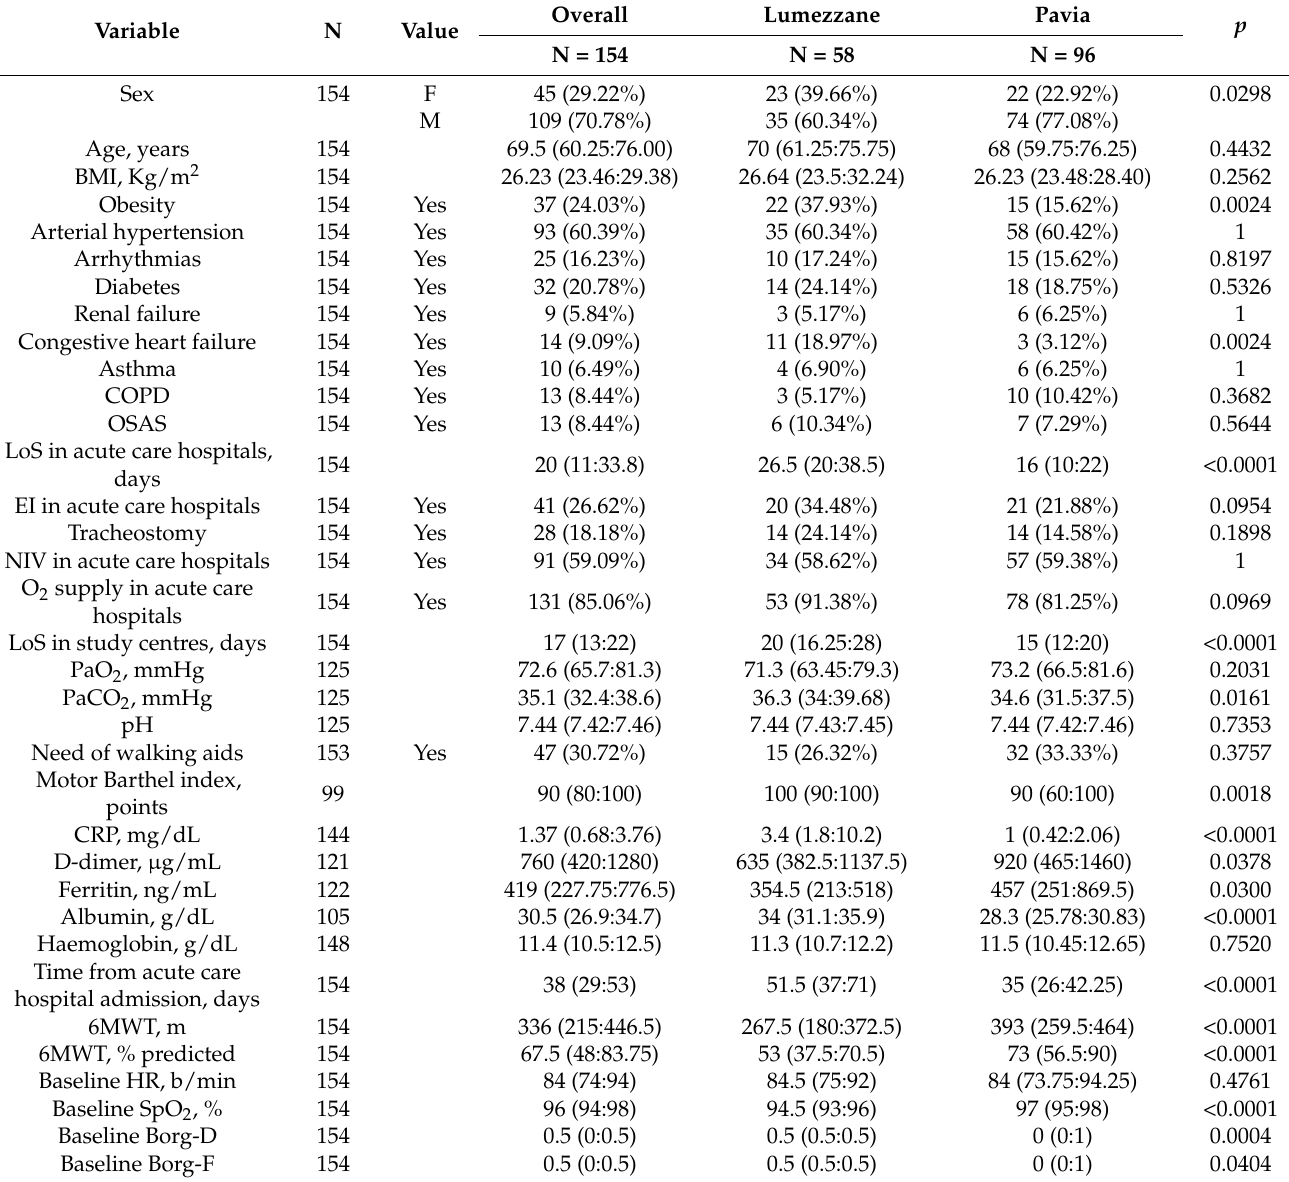
Table 1. Characteristics of studied patients overall and by